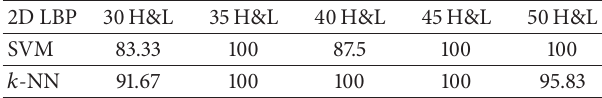
Table 7: The performance of classifiers for the FSVL model when the 2D LBP scheme is used for feature extraction.